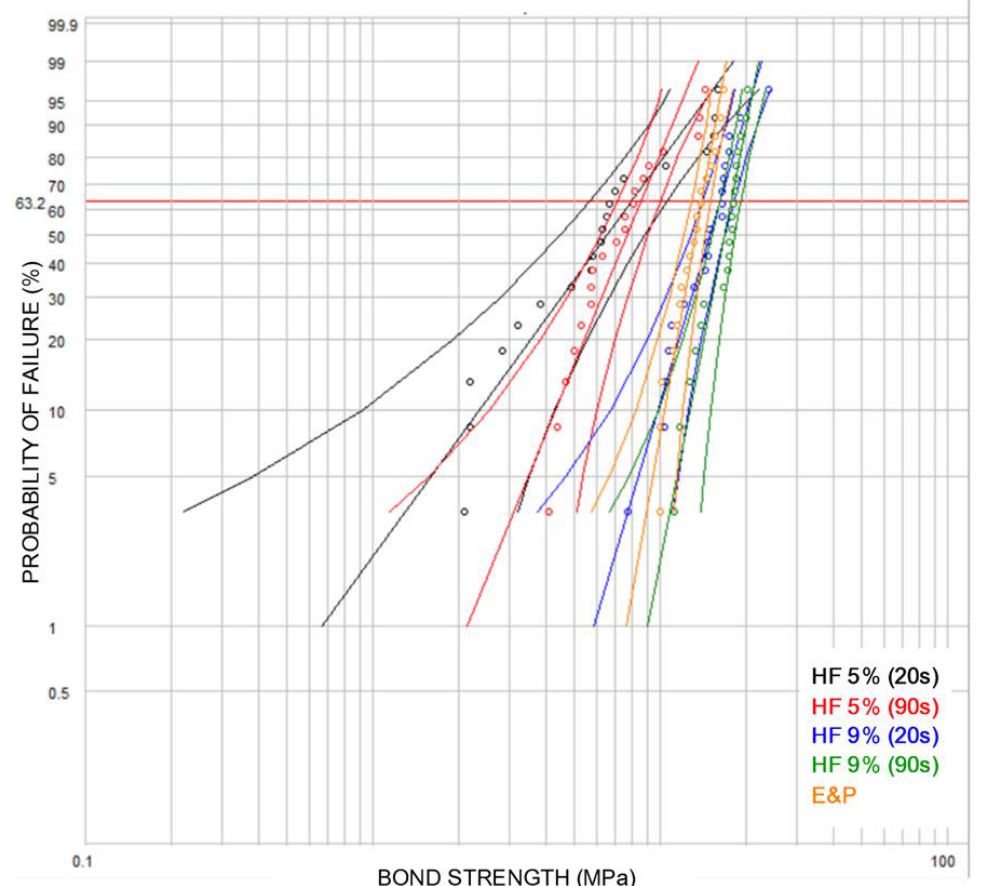
Figure 2. Weibull graphs for the treatments with 5% HF (20 and 90 s), 9% HF (20 and 90 s) and Etch and Prime (EP). Reliability is indicated by the slope of the graph. The characteristic life is indicated by the intersection of the graph with 63.2% probability (horizontal line).